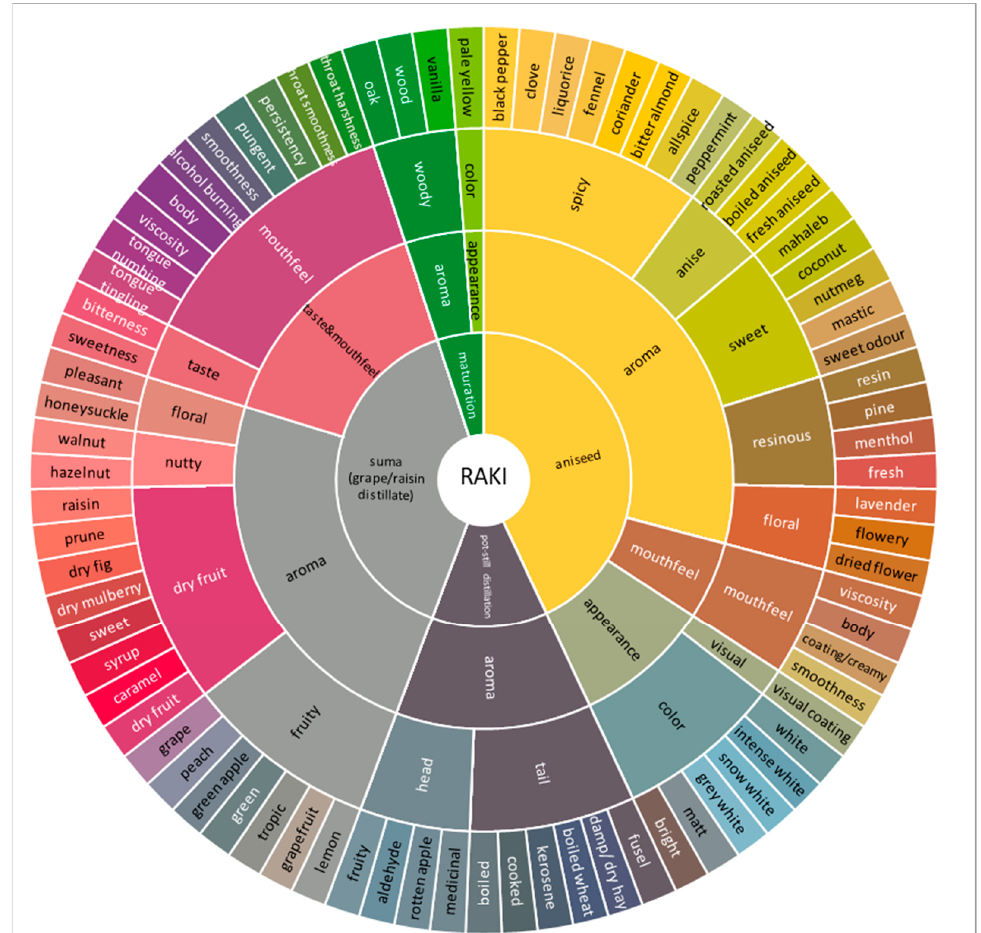
Figure 1. Sensory wheel of Rak ı